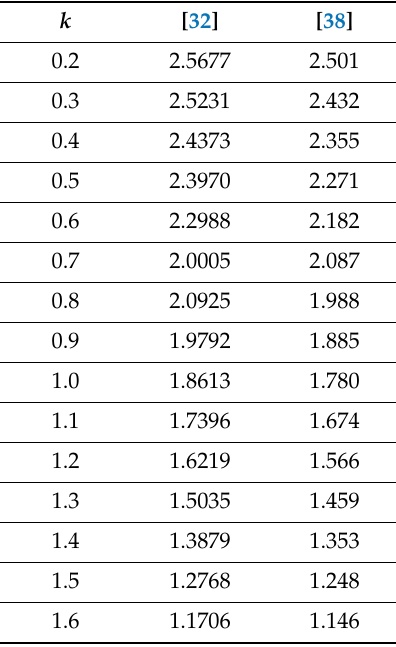
Table 8. Photoionization cross-section (Mb) of Li + using 165 terms in the Hylleraas wave function for the bound state wave function. The outgoing momentum of the electron is k